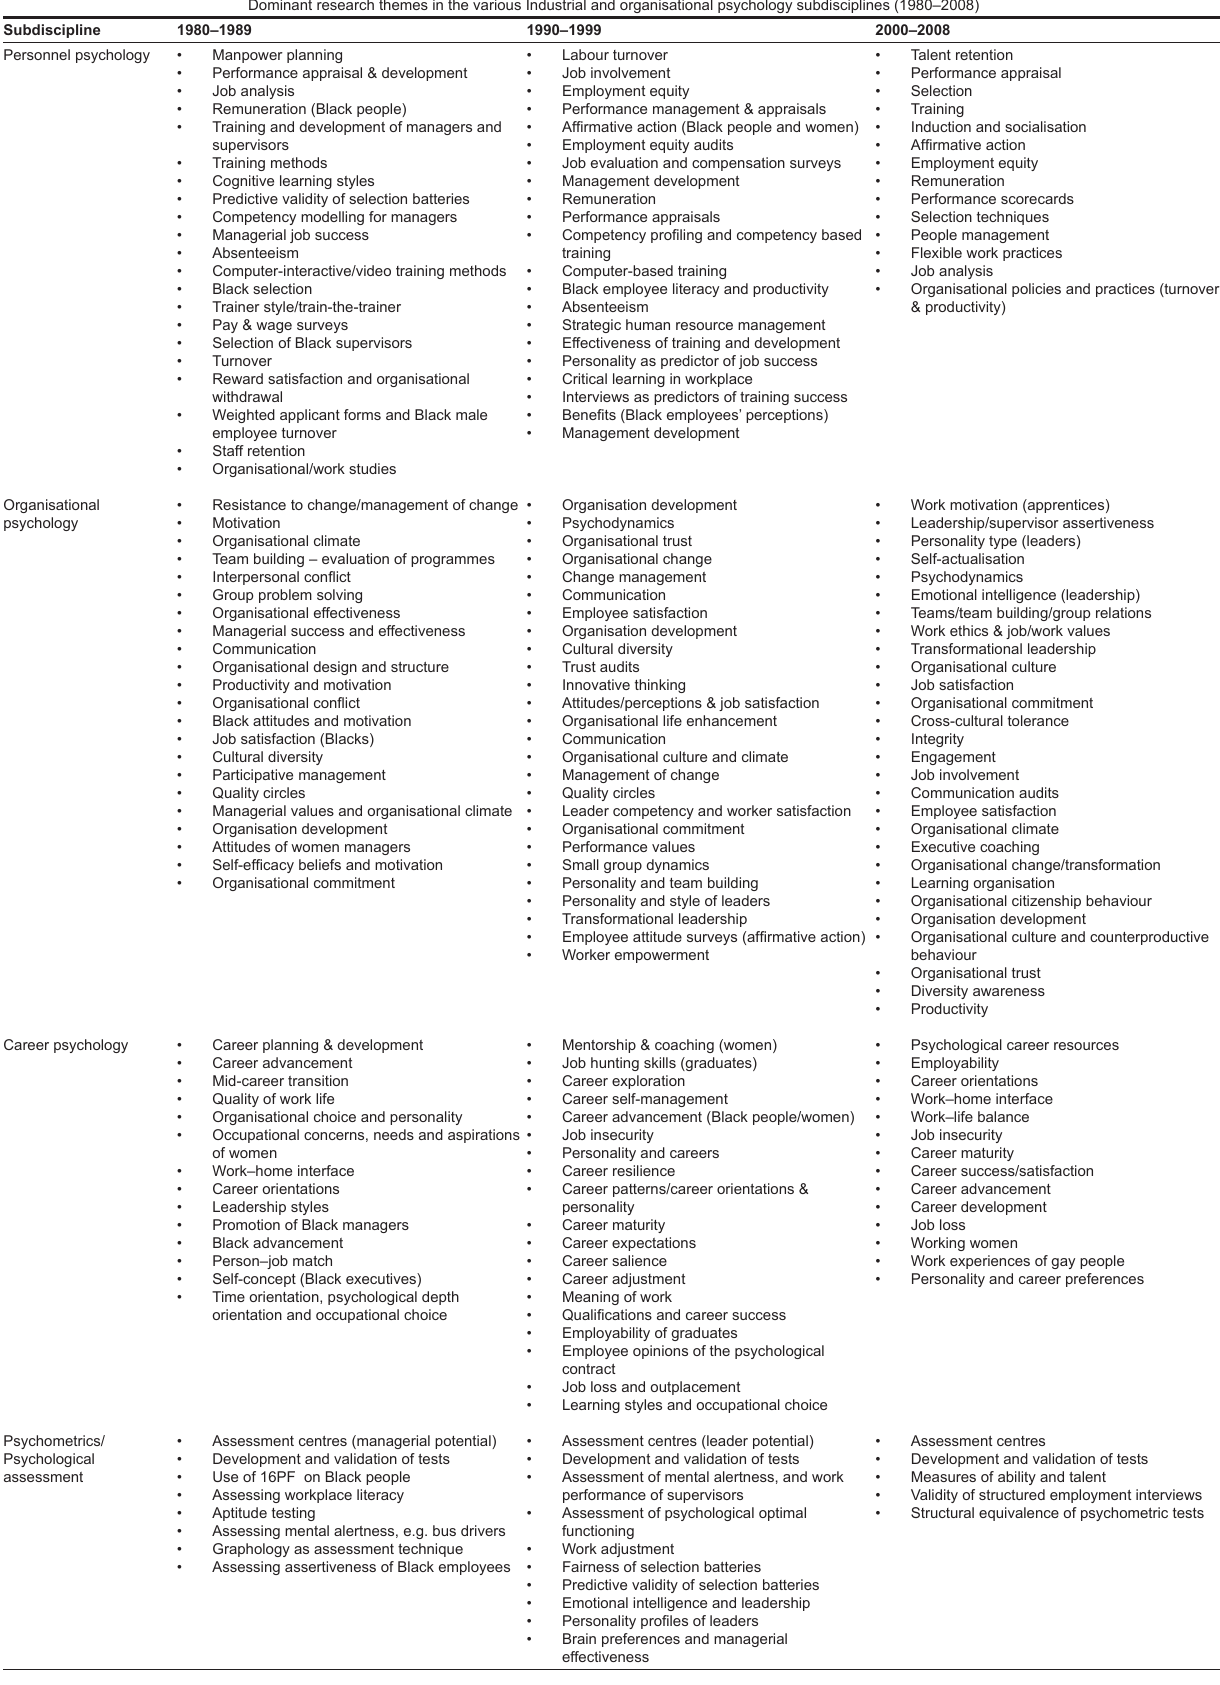
TABLE 4 Dominant research themes in the various Industrial and organisational psychology subdisciplines